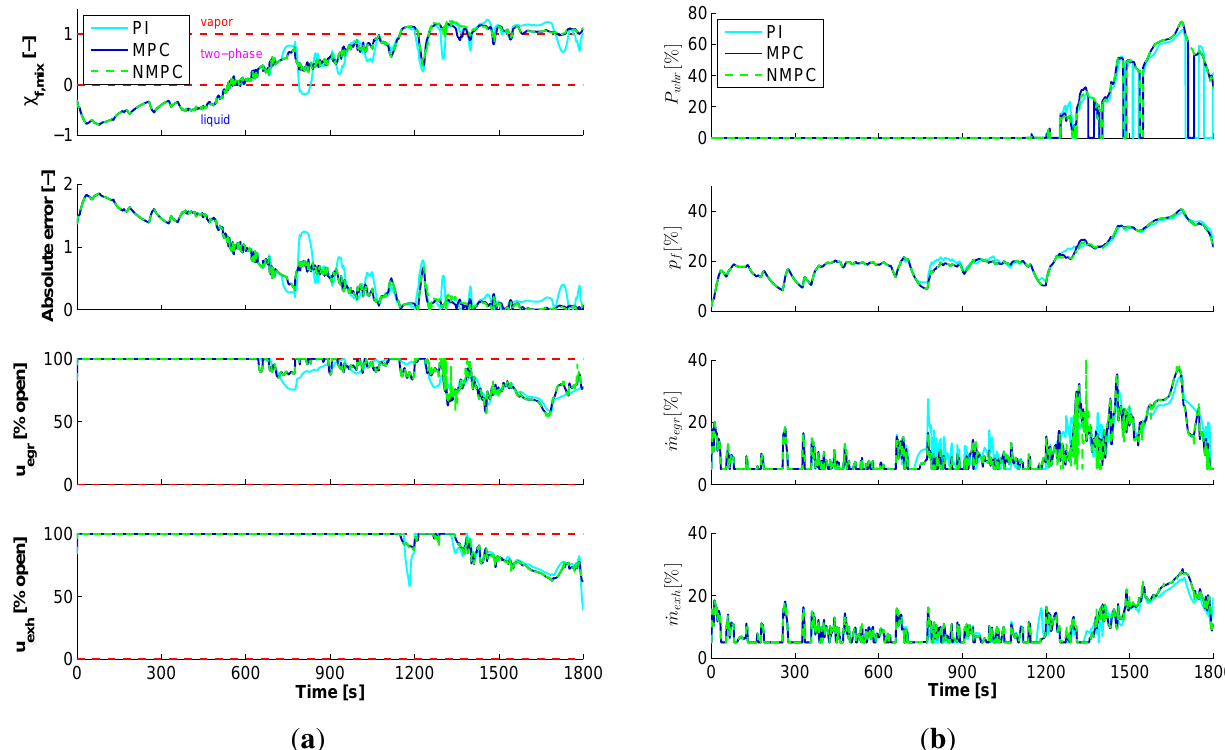
Figure 10. ( a ) Vapor fraction after the mixing junction, absolute error and control inputs for proportional-integral (PI), model predictive control (MPC) and nonlinear MPC (NMPC) control strategy for a cold-start WHTC; ( b ) WHR system net output power, system pressure and mass flow rates through the EGR and EXH